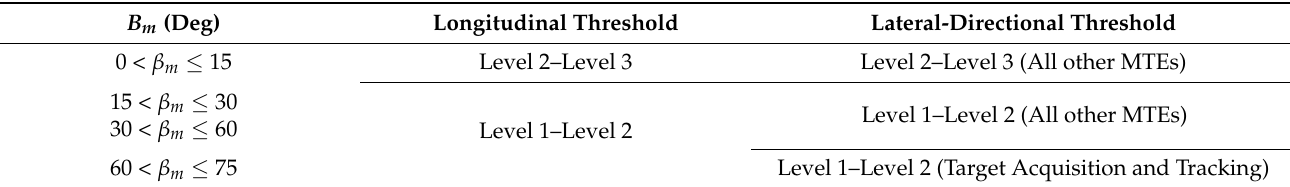
Table 2. Eigenvalue thresholds for uncertainty quantification.